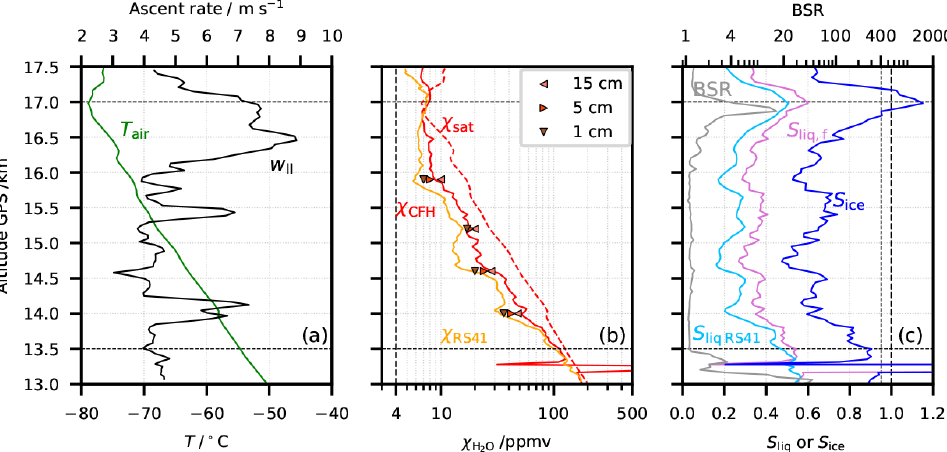
Figure 13. Flight NT011 and FLUENT simulation results for sublimation in the upper troposphere. (a) Green: air temperature; black: ascent velocity. (b) Red: H 2 O mixing ratio by the CFH; orange: H 2 O mixing ratio by the RS41; dashed red: saturation H 2 O mixing ratio for the air (cid:105) temperature; symbols: FLUENT simulation results for the tube average mixing ratios (cid:104) χ H Vol in tubes with different ice-coating depths d 2 O (full circumference): (cid:74) d = 15cm; (cid:73) d = 5cm; (cid:72) d = 1cm; (c) light blue: saturation over water ( S liq , RS41 ) by the RS41; pink: saturation over water ( S liq , f ) from the CFH considering the deposit on the mirror to be frost; blue: ice saturation ( S ice ) from the CFH; grey: 940nm backscatter ratio from the COBALD. Horizontal dashed lines limit the integration interval used for estimating the sublimated ice in the upper troposphere. Table 6. FLUENT input values ( P , T and background χ H for typical tropospheric and stratospheric conditions) for simulations of 2 O contamination stemming from the balloon envelope and resulting χ H directly ( d = 0m) and 5 to 10m displaced from under the balloon 2 O ( d = 5–10m), 55m below the balloon–payload (CFH) location. The balloon radius changes with height. Two different balloon ascent velocities ( w ) were considered. p T r balloon Background χ H 2 O